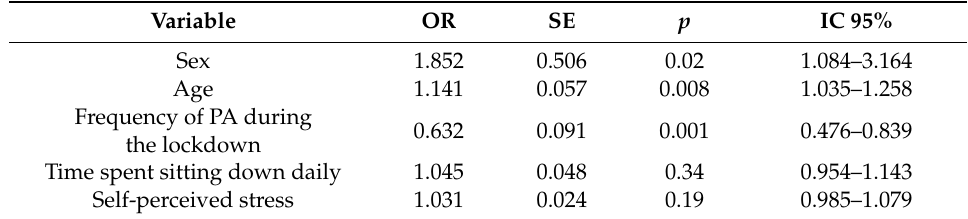
Table 3. Binomial logistic regression of musculoskeletal pain in relation to gender, physical activity, and emotional